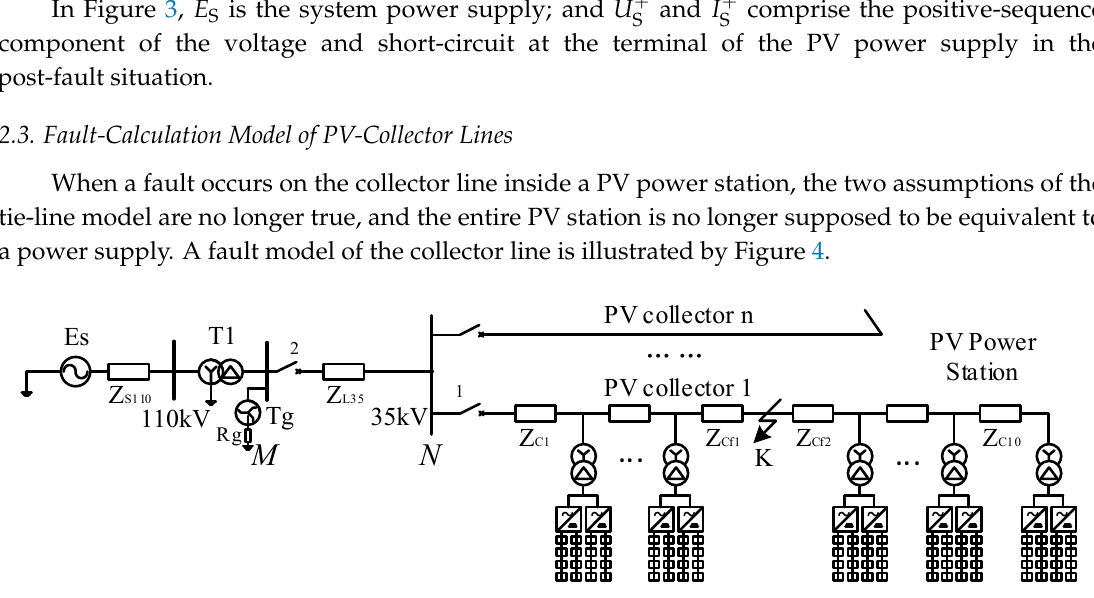
Figure 3. Fault sequence network for the fault on the tie-line.